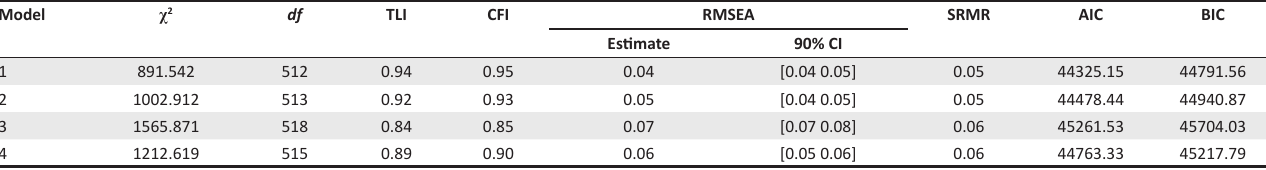
TABLE 3: Goodness-of-fit statistics of competing measurement models. Model